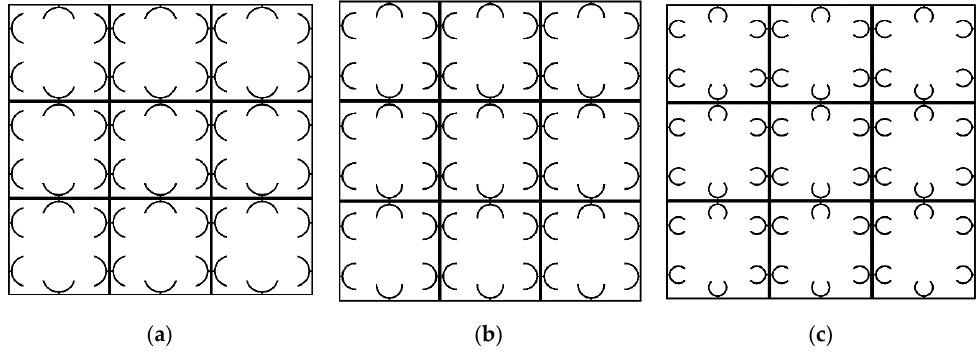
Figure 16. Band structure and mode shapes of the parallel metastructure.